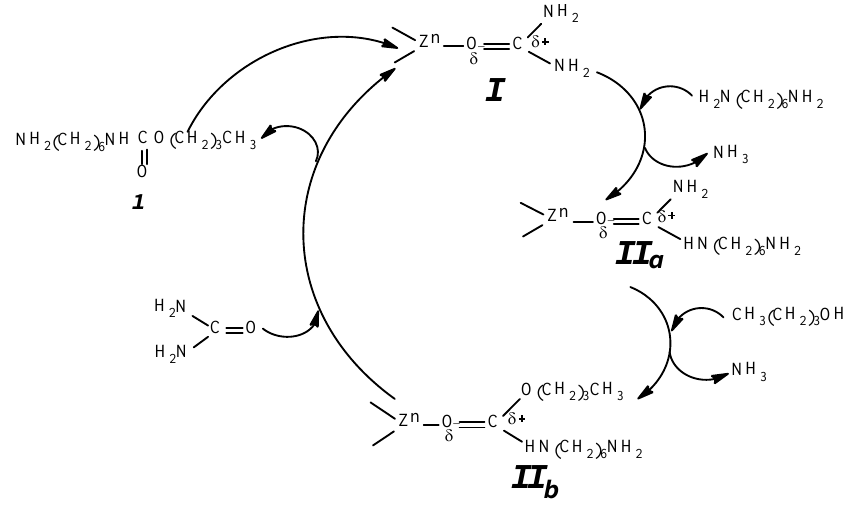
Scheme 2. Possible mechanism for the formation of 1 via one-pot reaction of HDA, urea, and butanol using ZnAlPO 4 as a catalyst. 1 : butyl 6-aminohexyl-1-carbamate.